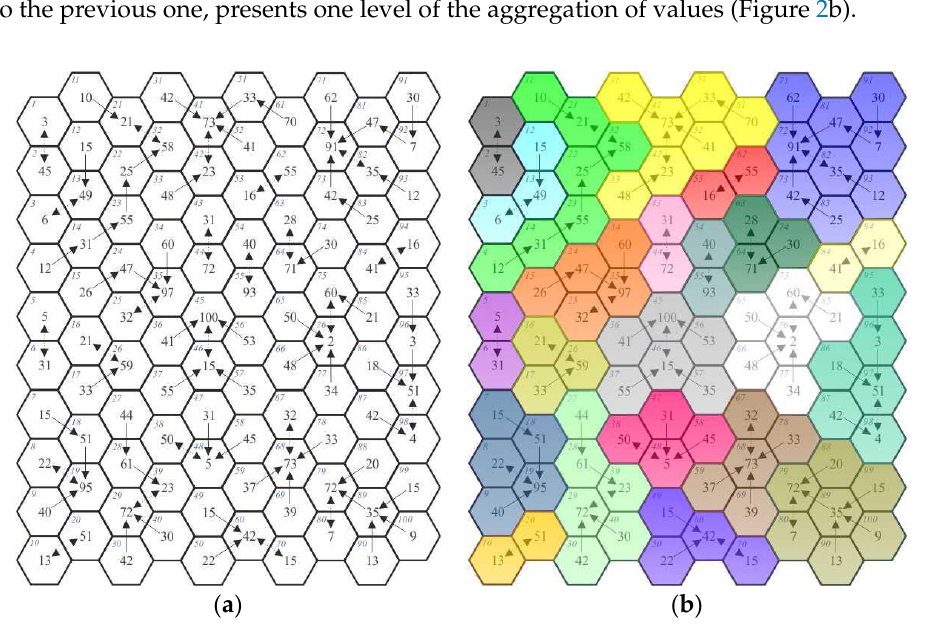
Figure 2. The stages of network emergence according to the maximum value difference path: ( a ) the stage of revealing the maximum difference relationship; ( b ) the first stage of value aggregation and the emergence of new regions. Source: Own analysis.